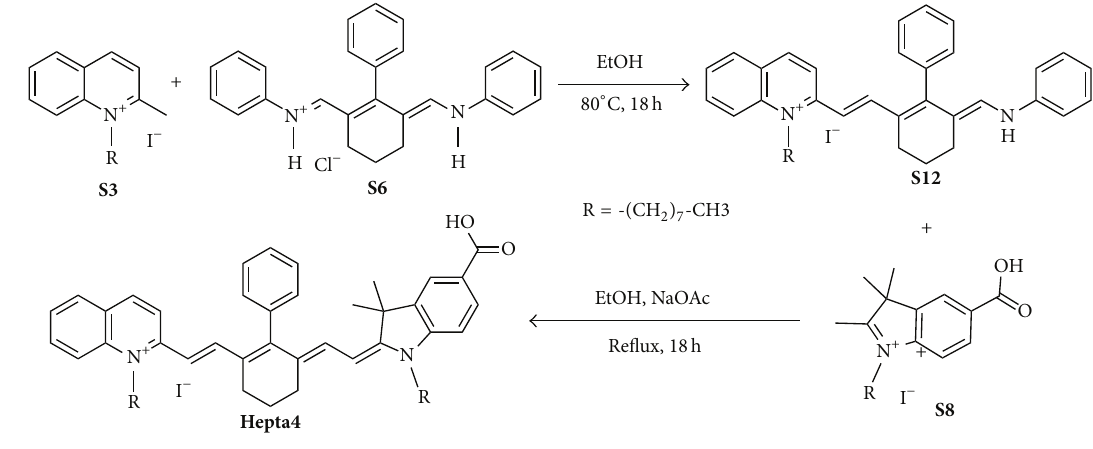
Scheme 1: Synthetic route of Hepta4